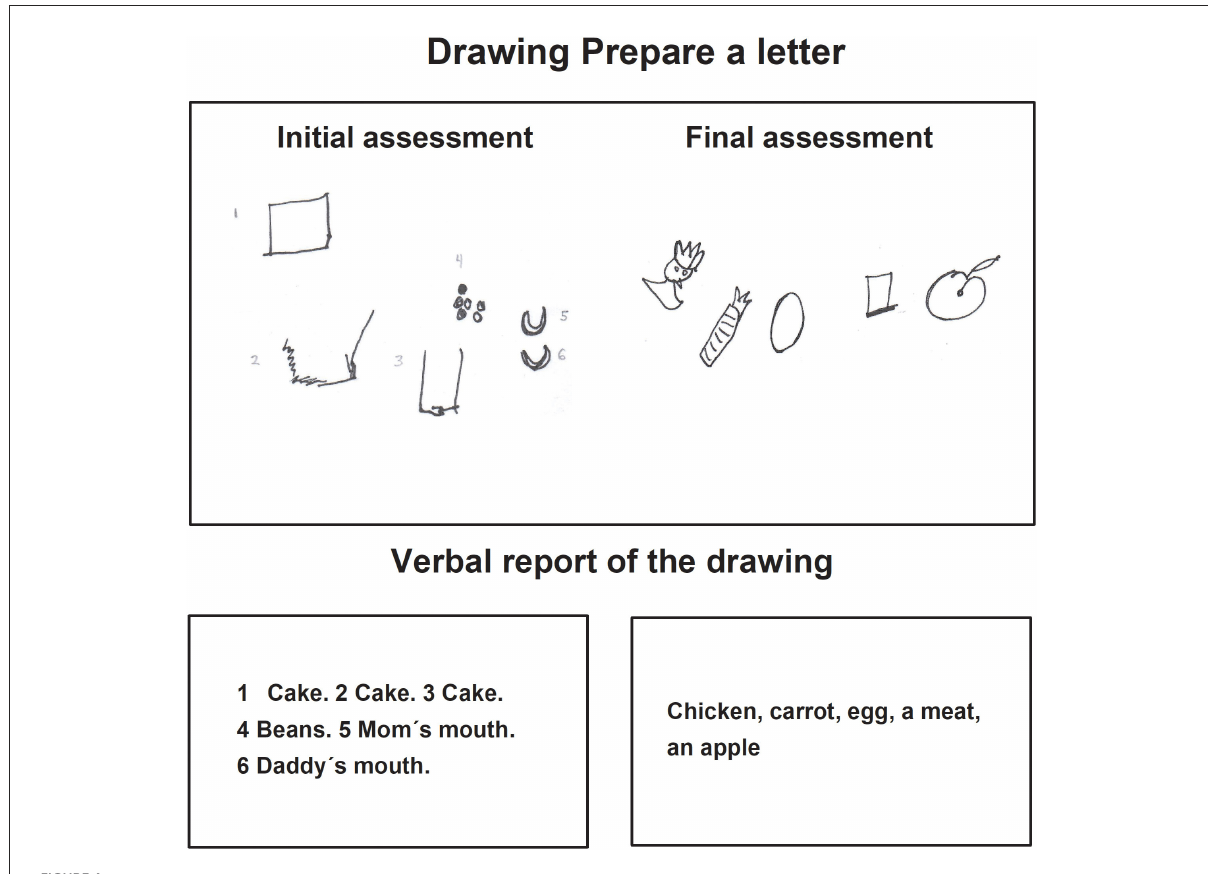
FIGURE4 Child D drawing of the task prepare a letter, during the initial and final